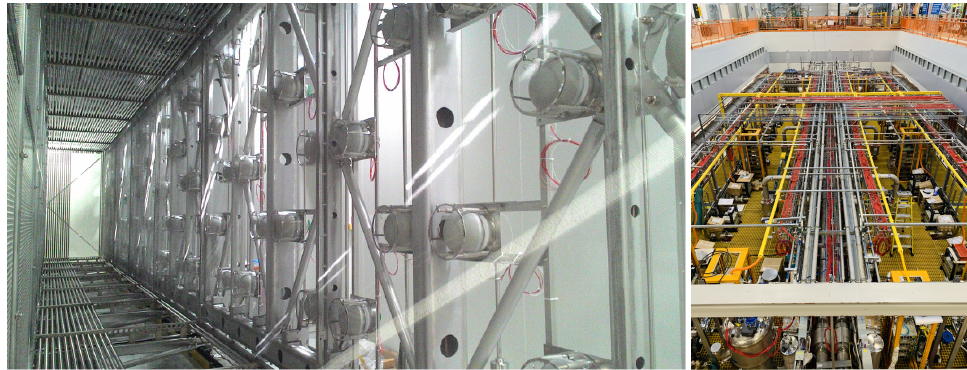
Figure 13. ( Left ): Deployment the upgraded ICARUS-T600 PMT system behind a wire plane of one of the four TPCs during the overhauling activities at CERN. ( Right ): Status of the ICARUS-T600 plant at Fermilab before the beginning of the cryogenic commissioning in